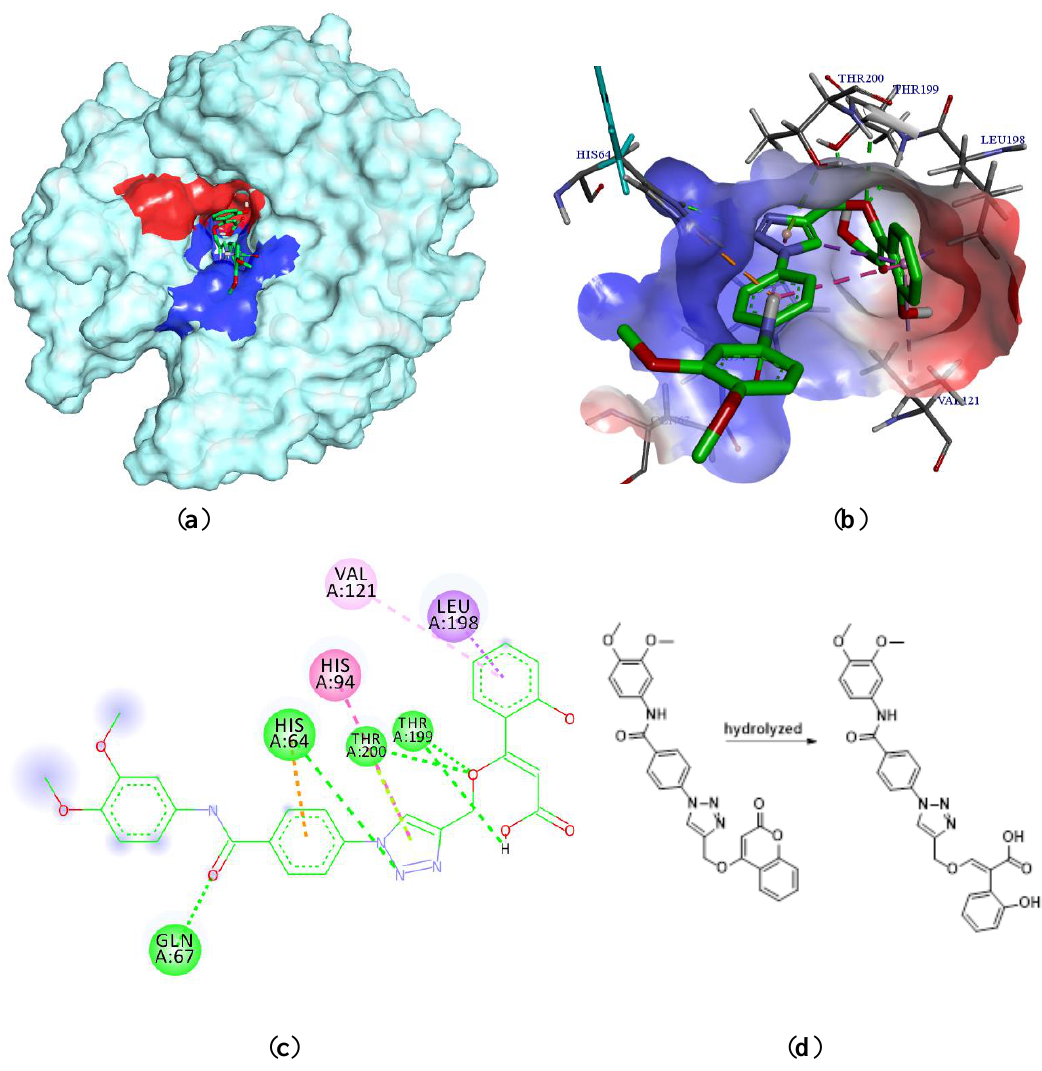
Figure 4. Interaction diagrams of the selected docked conformations for hydrolyzed compound 5e inside the active site of CA IX enzyme. ( a ) The surface representation of binding pocket has been shown at the top of the figure. ( b ) 3D ligand interactions diagram. ( c ) 2D ligand interactions diagram. ( d ) The ligand of this docking